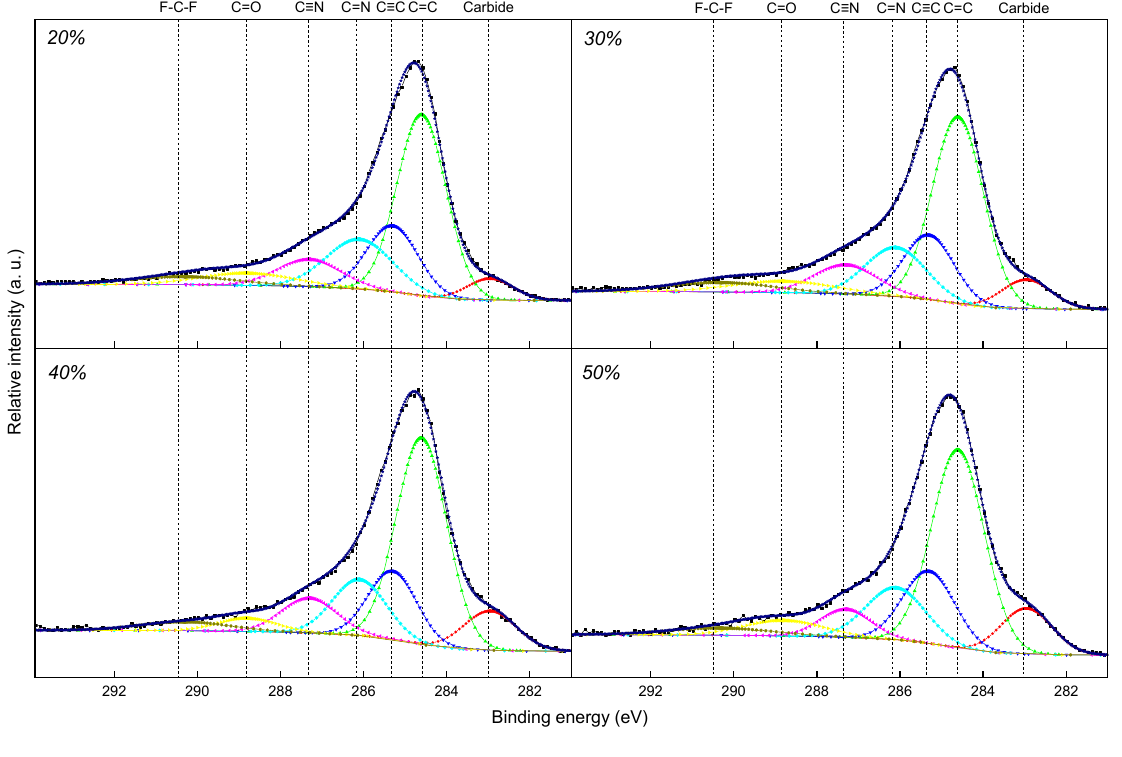
Figure 3. XPS C 1s spectra of carbon-doped TiZrN. Table 1. Carbon bonding ratio of carbon-doped